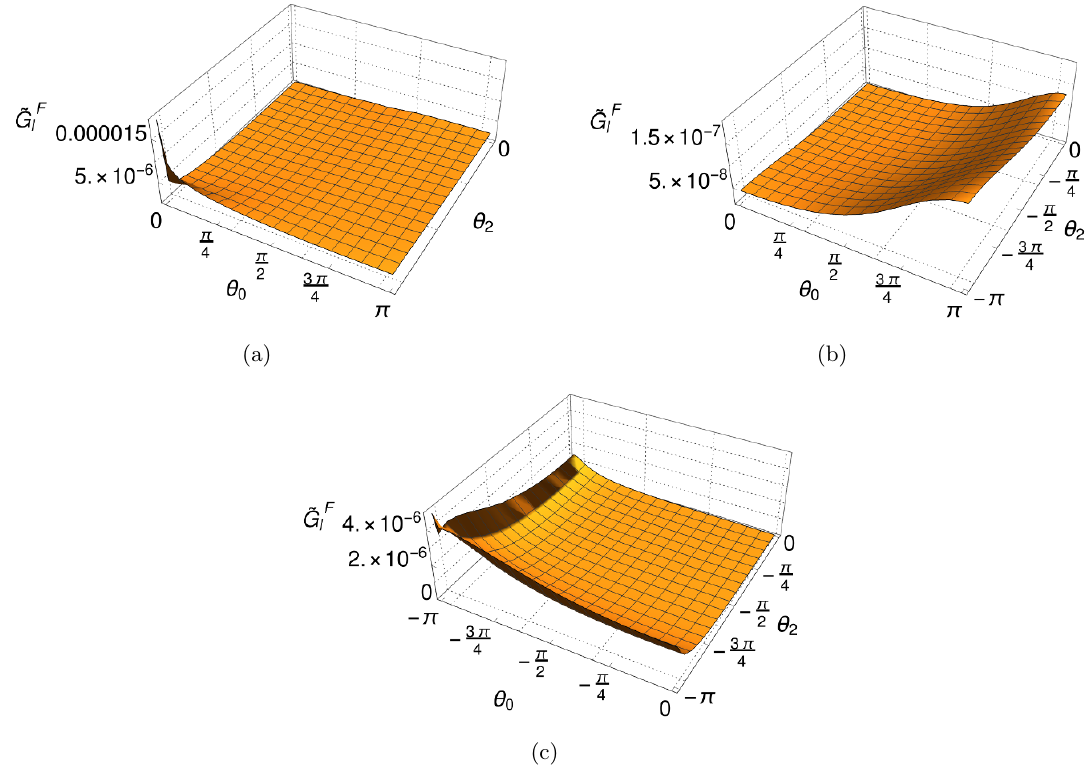
Figure 16 . The (cid:12)rst subsector of I10 at O ( (cid:15) 0 ) after OT3 at; (a) a near threshold point u = 179574 GeV 2 , (b) a point a reasonable distance over the threshold u = 748225 GeV 2 , (c) a